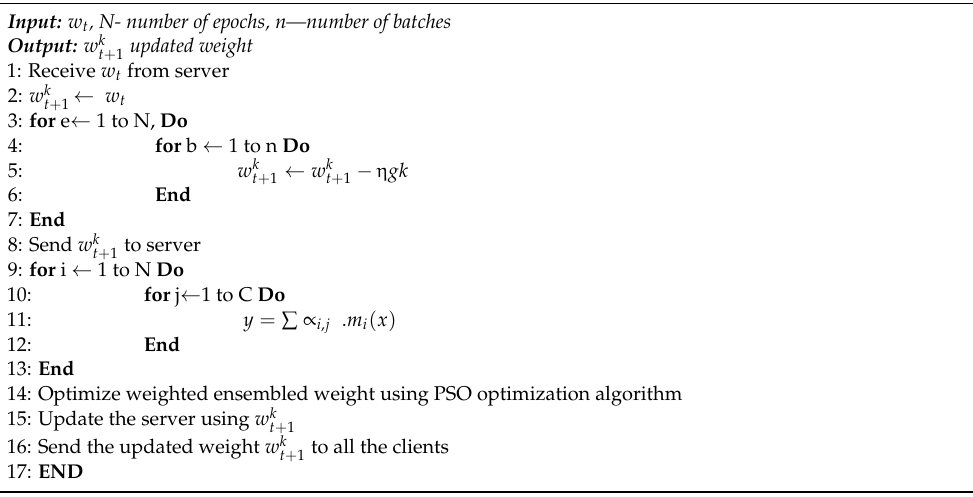
Algorithm 1: Algorithm for intrusion detection based on the distributed FL of heterogeneous neural networks